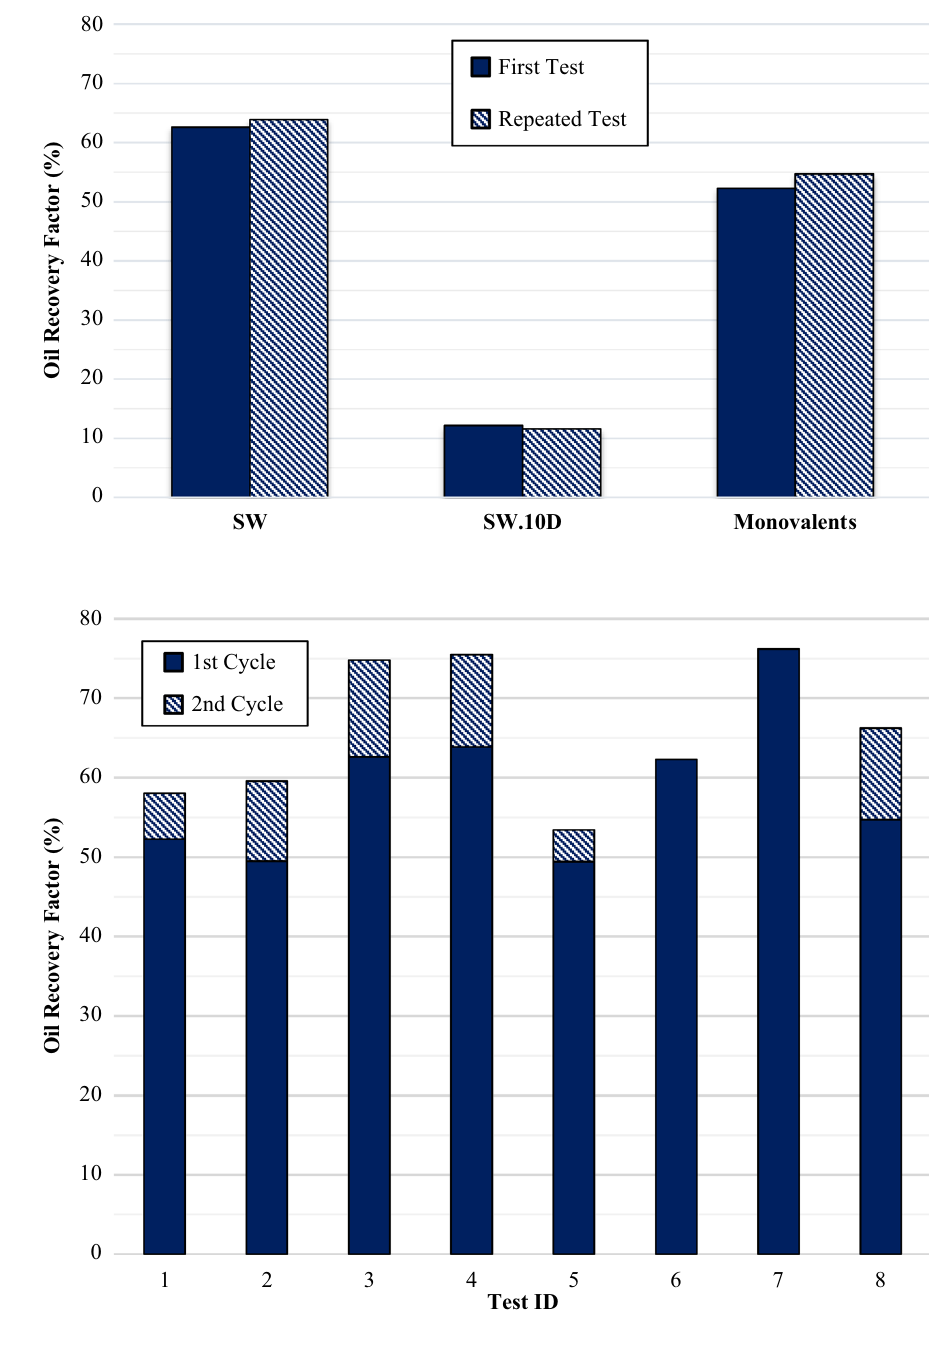
Fig. 3 Repeatability of the performed scenarios at 90 °C. The dashed columns represents the results of repeated tests